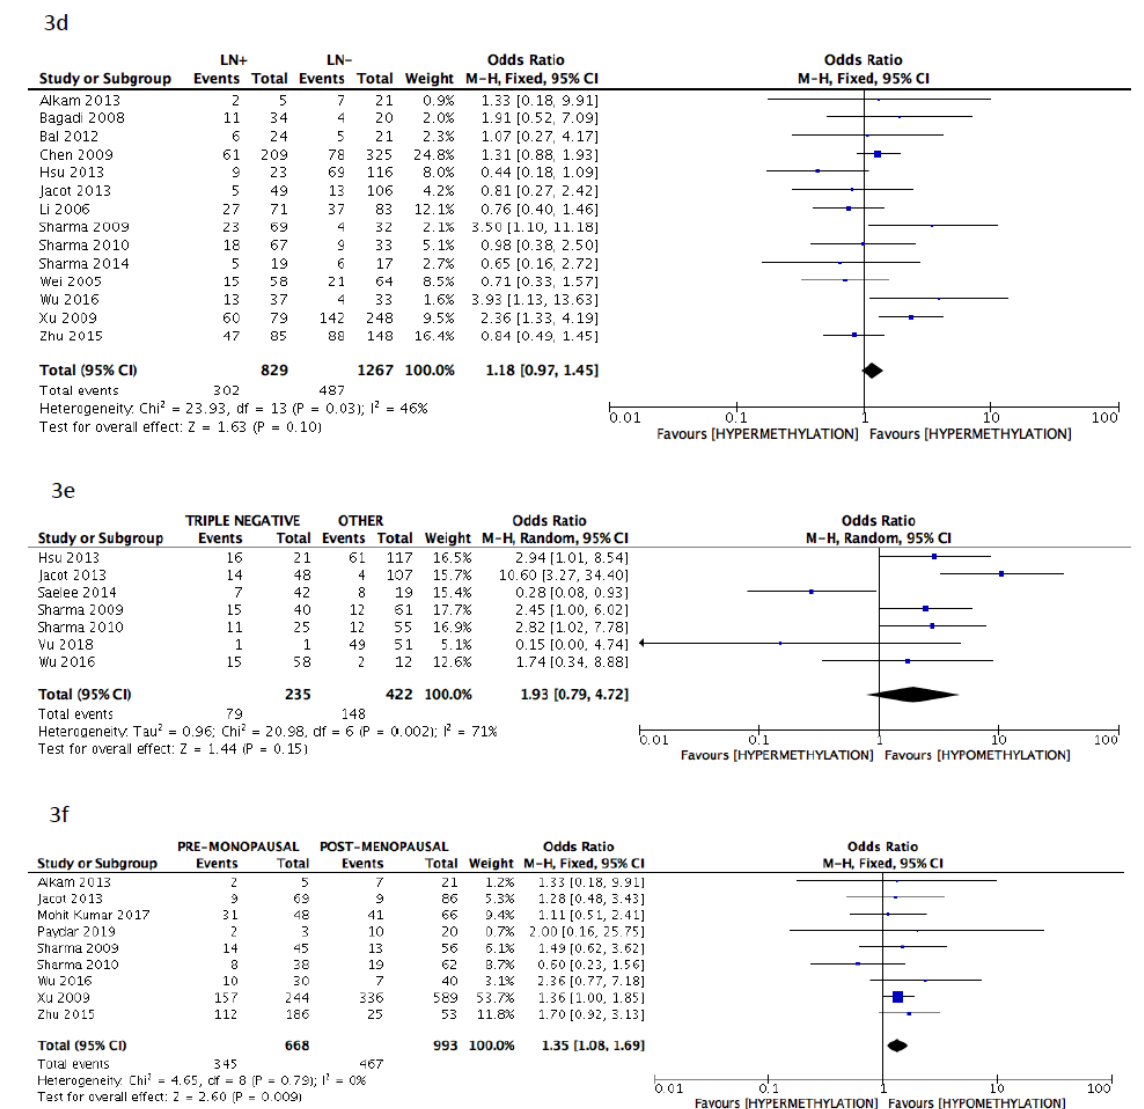
Figure 3. Pooled results on forest plots about the correlation between BRCA1 gene methylation status with breast cancer patients’ clinicopathological characteristics. In this subanalysis, only studies adopting methylation-specific PCR (MS-PCR) methodology for the detection of BRCA1 methylation status were included. Events= number of BRCA1 gene hypermeth- ylated cases. Figure shows the correlation between BRCA1 gene methylation and histology (3 a ), disease stage (3 b ), tumor grading (3 c ), lymph nodal status (3 d ), molecular classification (3 e ) and menopausal status (3 f ).